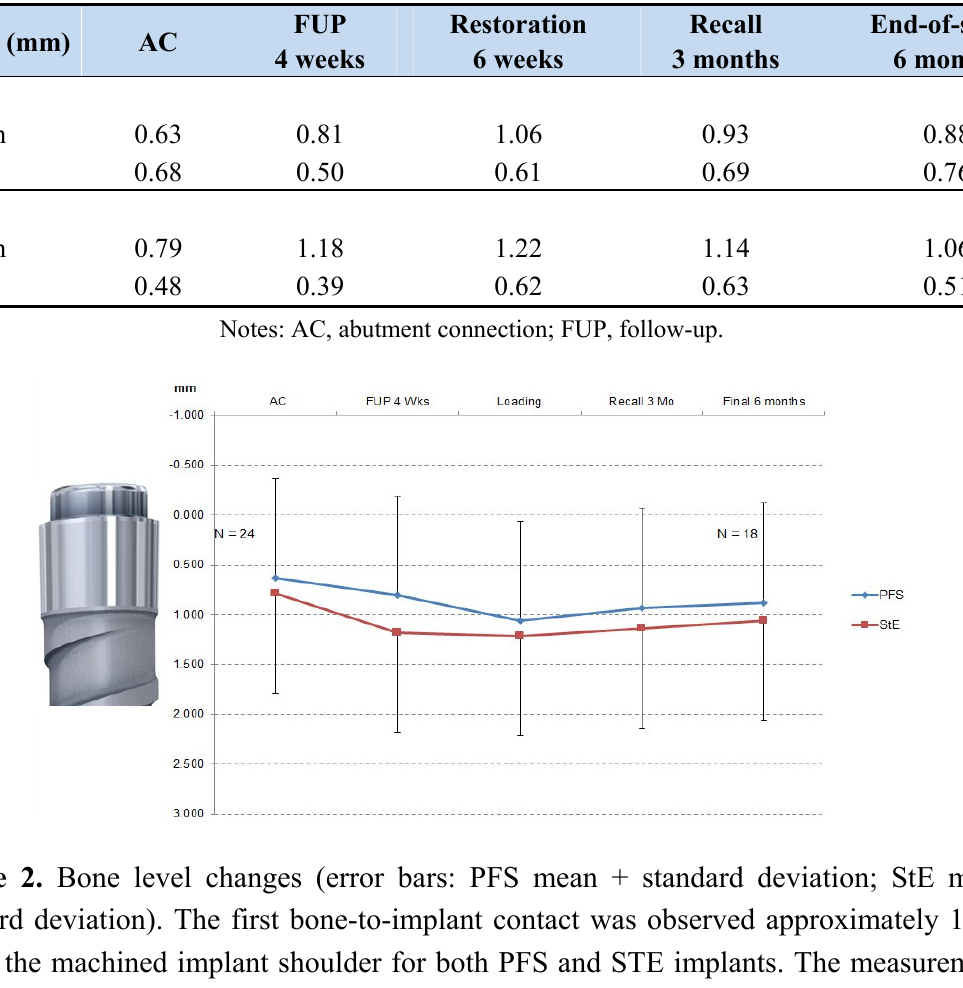
Table 1. Quantitative X-ray analysis. Results of the bone-to-implant distance measurement. Mesial and distal values were averaged.